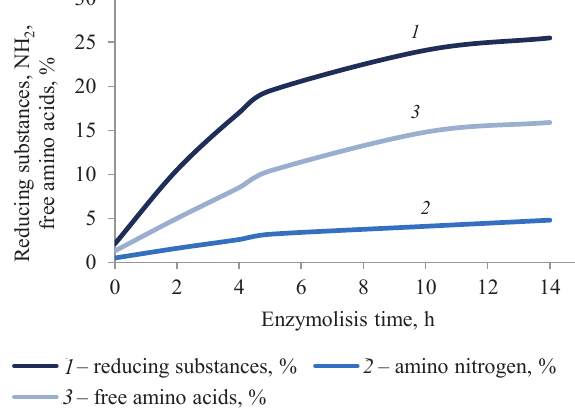
Figure 3 Biochemical parameters of the enzymatic hydrolysates during hydrolysis of the microbial biomass mix ( Aspergillus oryzae and Sаcharomyces cerevisiae